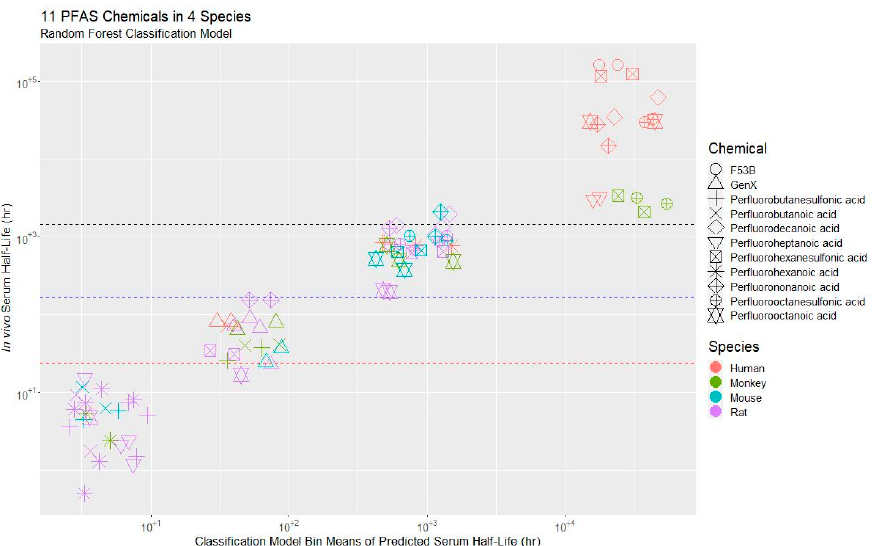
Figure 2. Values of t ½ of the training data ( y -axis) vs. classification predictions by the RF Classification model using 15 predictors. Colors signify species, while shapes indicate different PFAS compounds. Bin margins (<12 h, 12 h − 1 week, 1 week–2 months, >2 months) are indicated as dotted lines. Note that observations have been jittered (that is, a small amount of random variation has been added) along the x -axis to increase readability.